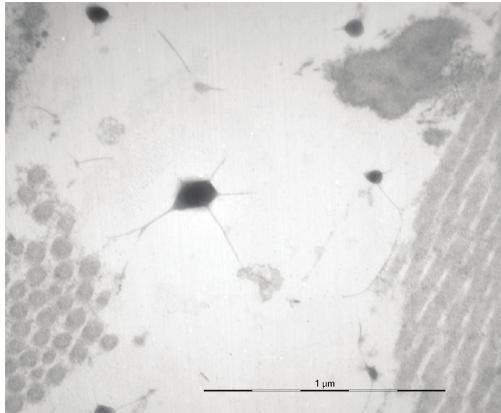
Figure 3: Globules of presumably hyaluronic acid and granulofila- mentous meshwork inside the collagen